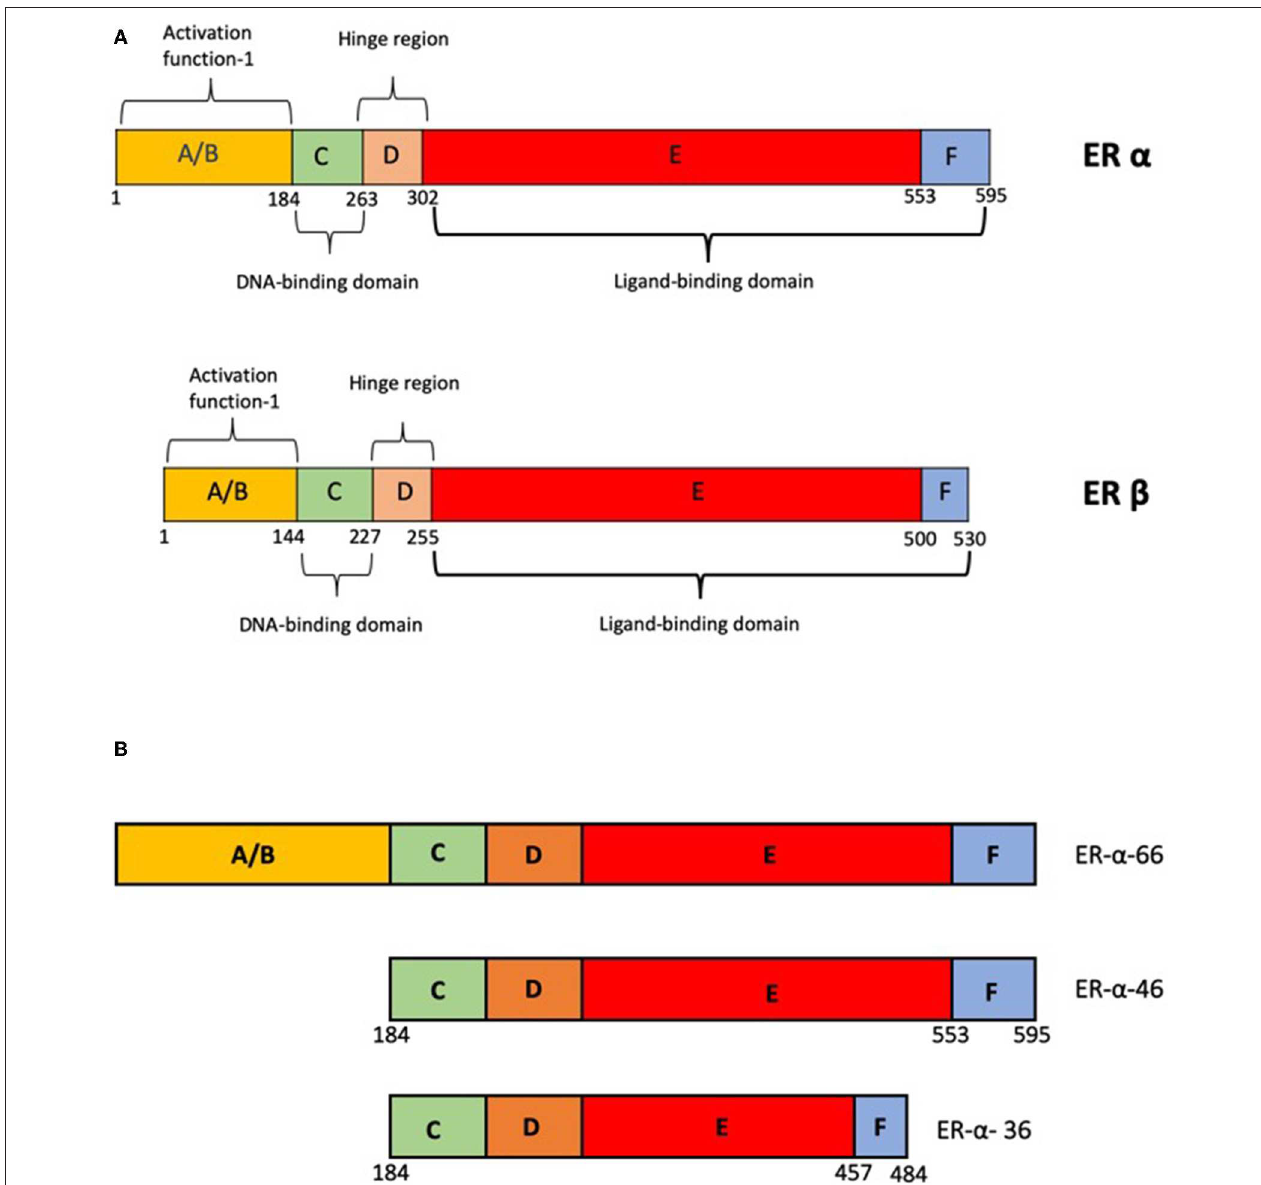
FIGURE 1 | (A) Schematic representation of the domain structure of ER- α and ER- β . (B) Schematic representation of alternate variants of ER- α -products of alternate